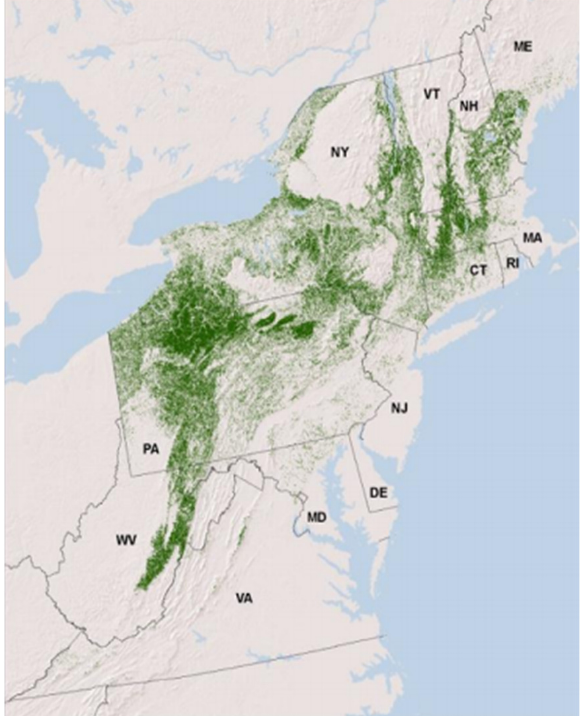
Figure 1. Map of the hemlock–northern hardwood forest. The Nature Conservancy, 2018.